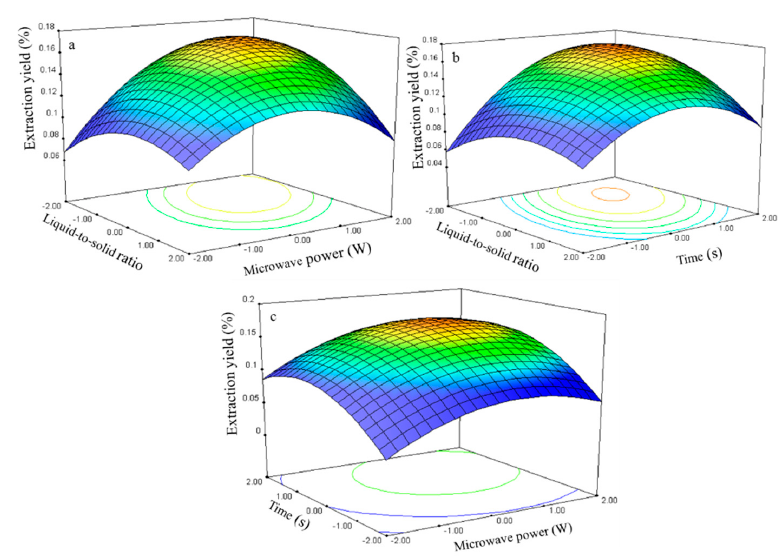
Figure 11. Response surface plots for the effects of ( a ) liquid-to-solid ratio/power ( b ) liquid-to-solid/time ( c ) power/time on the extraction yield of isorhamnetin.